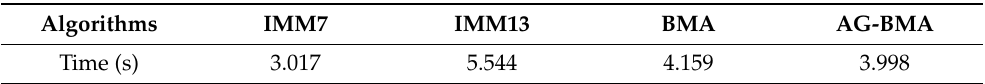
Table 5. Computational time taken by the four algorithms in RS.